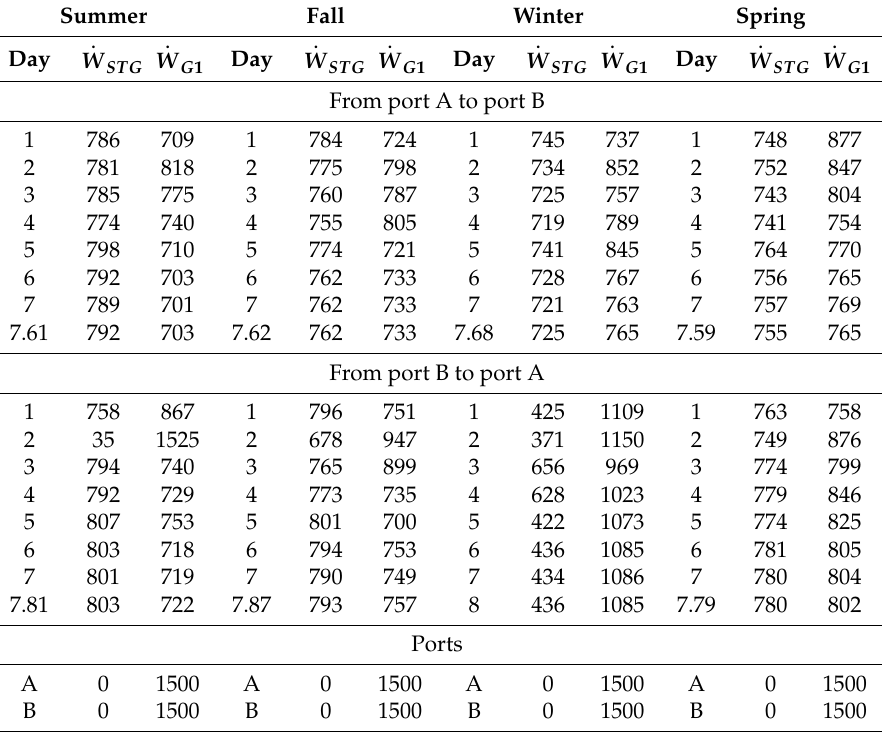
Table 33. Electric power of STG and DG versus time for all seasons (in kW).